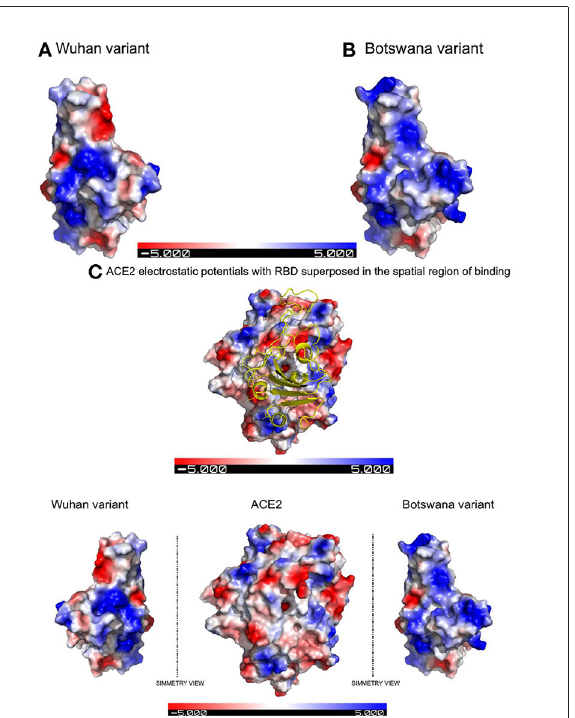
FIGURE2 Electrostatic potentials comparative in the RBD between both variants and their influence in binding with ACE2 due to the latter’s electrostatic potentials. (A) Electrostatic potentials in the wild-type RBD. (B) Electrostatic potentials in the RBD of the Botswana Omicron variant. (C) Representation of the spatial region showing of binding with the electrostatic potentials of the ACE2 protein superposed to the RBD of SARS-CoV-2 spike protein. (D) Symmetric comparation of the electrostatic potentials of both variants with de ACE2